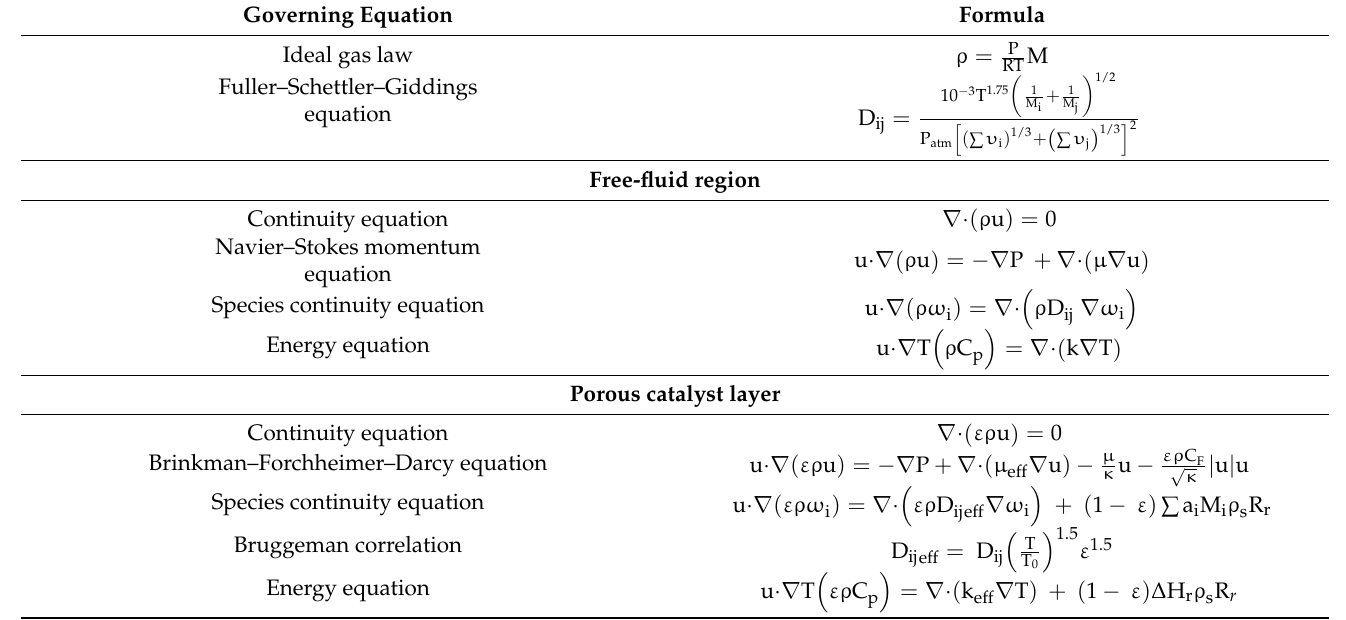
Table A1. Summary of CFD model governing equations. Adapted with permission from S. Chiuta, R.C. Everson, H.W.J.P. Neomagus, L.A. Le Grange, D.G. Bessarabov, International Journal of Hydrogen Energy; published by Elsevier, 2014